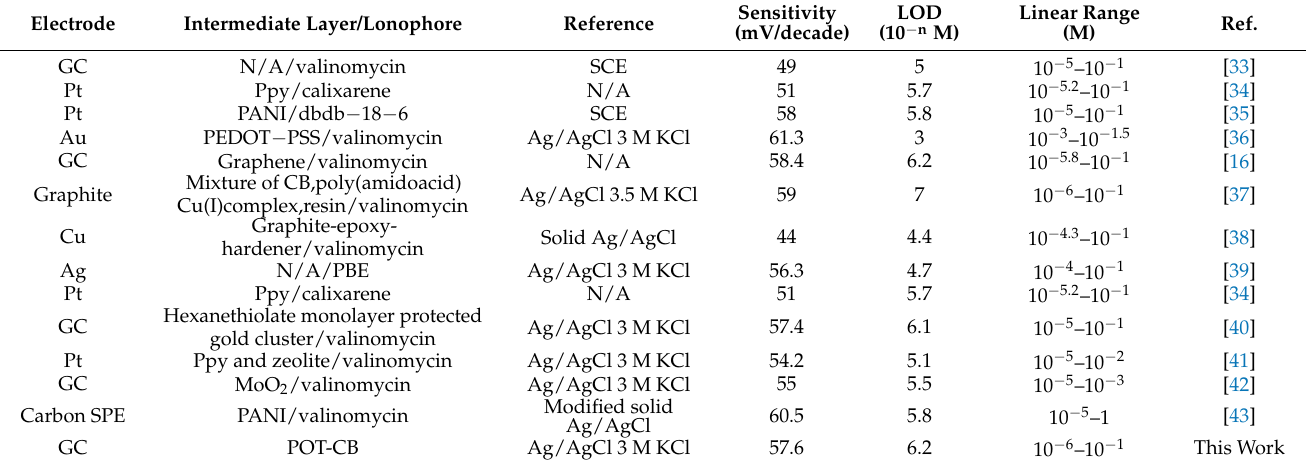
Figure 3. ( a ) Potential response diagram of GC/POT-CB/K + -ISE in KCl solution; ( b ) potential calibration curve of GC/POT-CB/K + -ISE.The red line is the linear fitting line of the electrode in the range of 10 − 6 –10 − 1 M. Table 1. Summary of Recent Studies of Solid-State Potassium Ion Selective